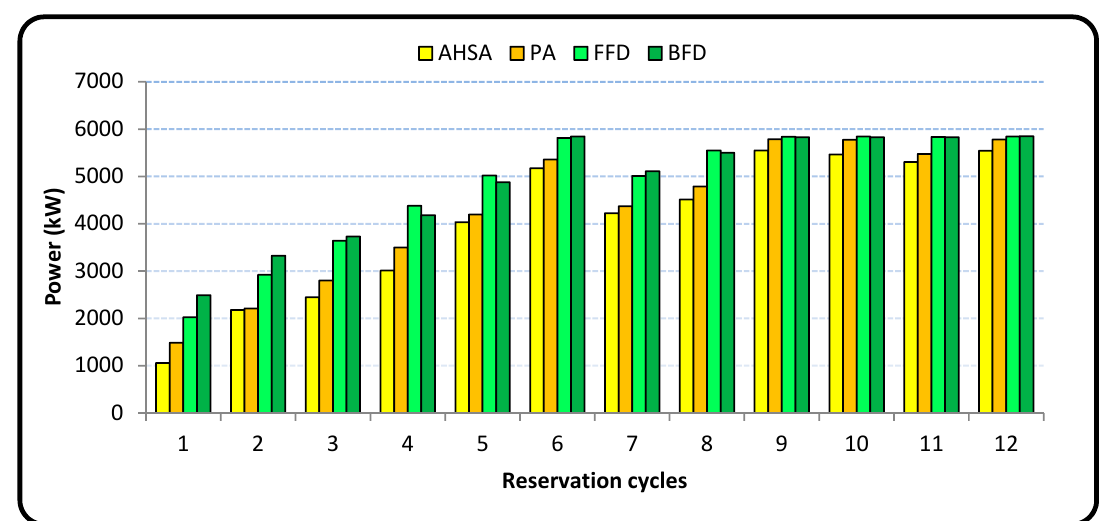
Figure 6. Power consumption Scenario I.